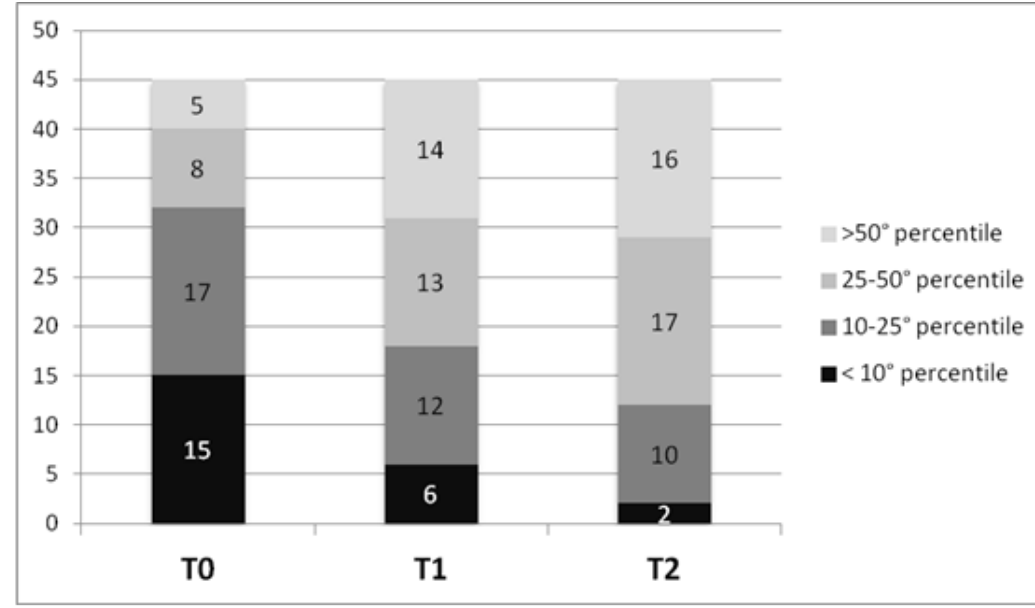
Figure 1. At each time (T0, T1, T2) patients are subdivided in groups based on the weight percentile. Two children did not show any improvement: one was a boy with congenital cardiomyopathy in Vici's syndrome who died 6 months after gastrostomy placement; the second one underwent gastrostomy placement at the age of 16 months, when he weighed 13.5 kg, and with a total weight gain of +4.6Kg in 3.8 years.